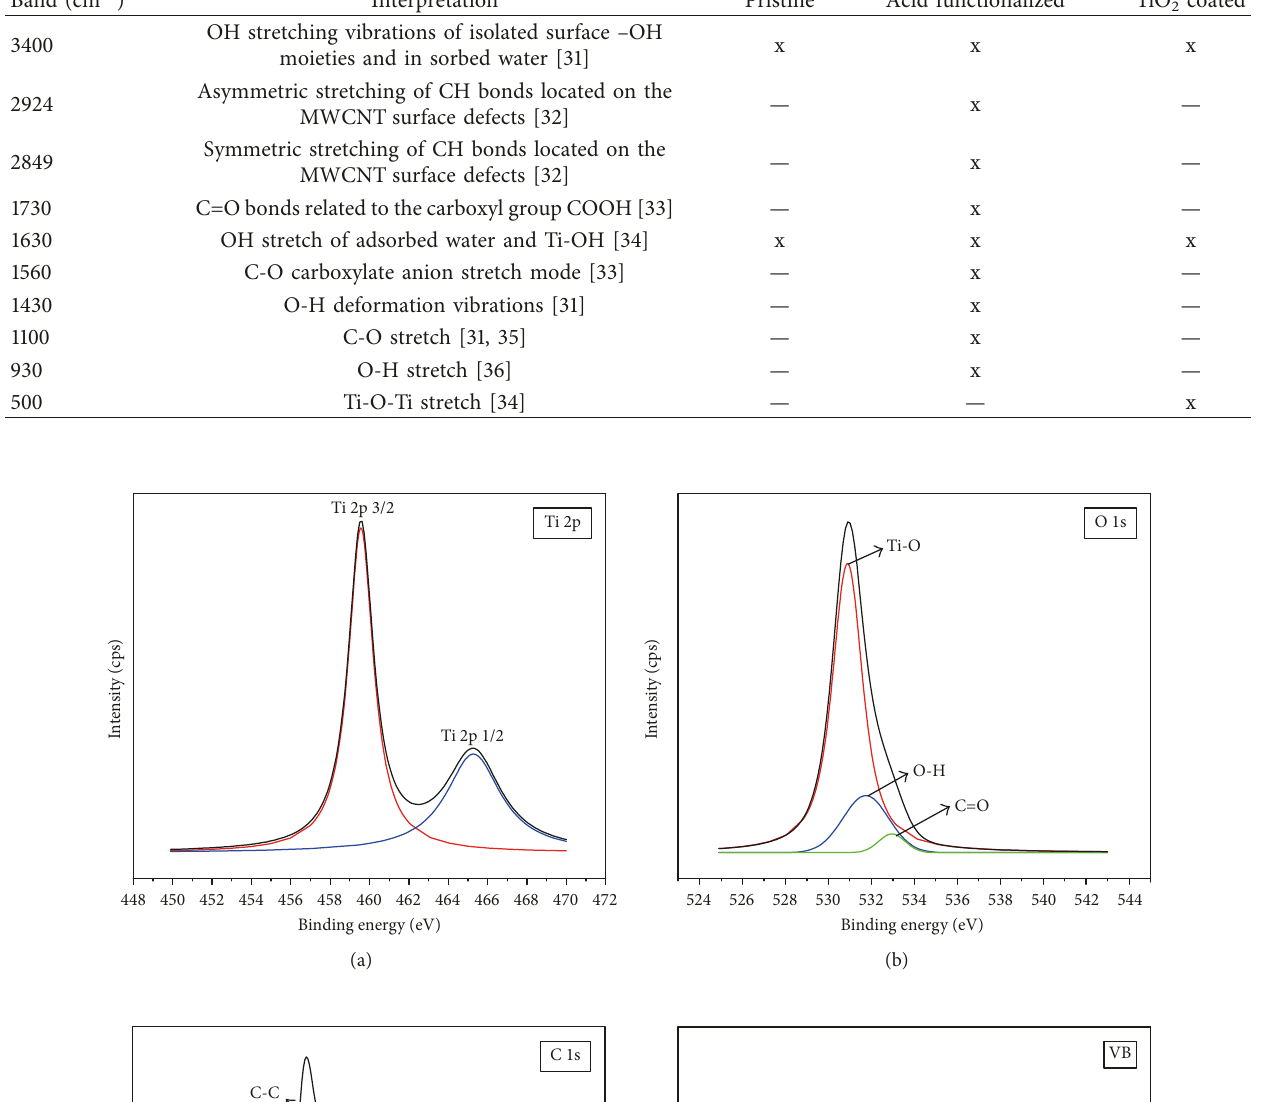
Table 1: FTIR bands observed for pristine, acid-functionalized, and TiO Band (cm